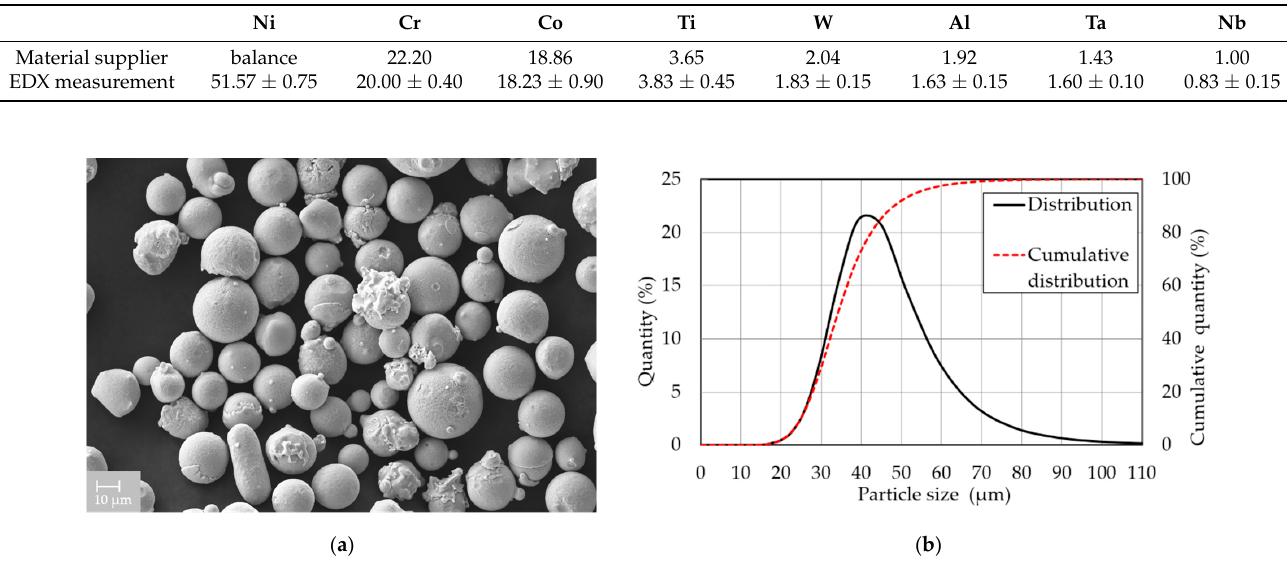
Figure 1. IN939 powder characterization: ( a ) SEM image showing mostly spherical particles; ( b ) particle size distribution.